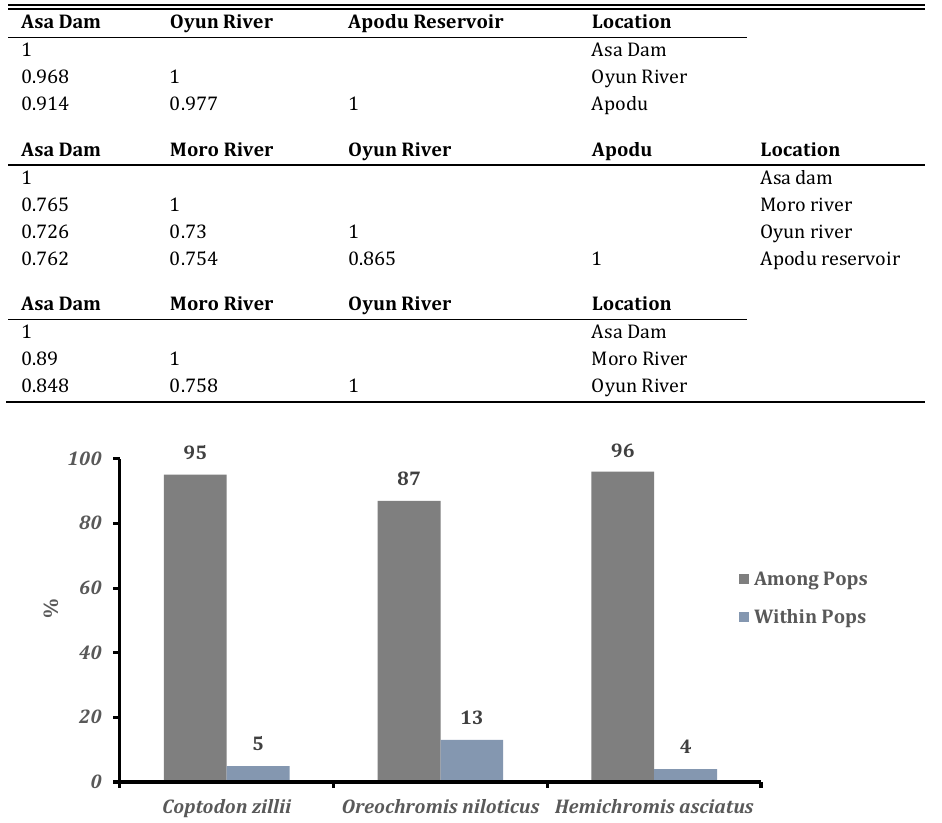
Figure 3 . Percentages of molecular variance within and among Cichlid